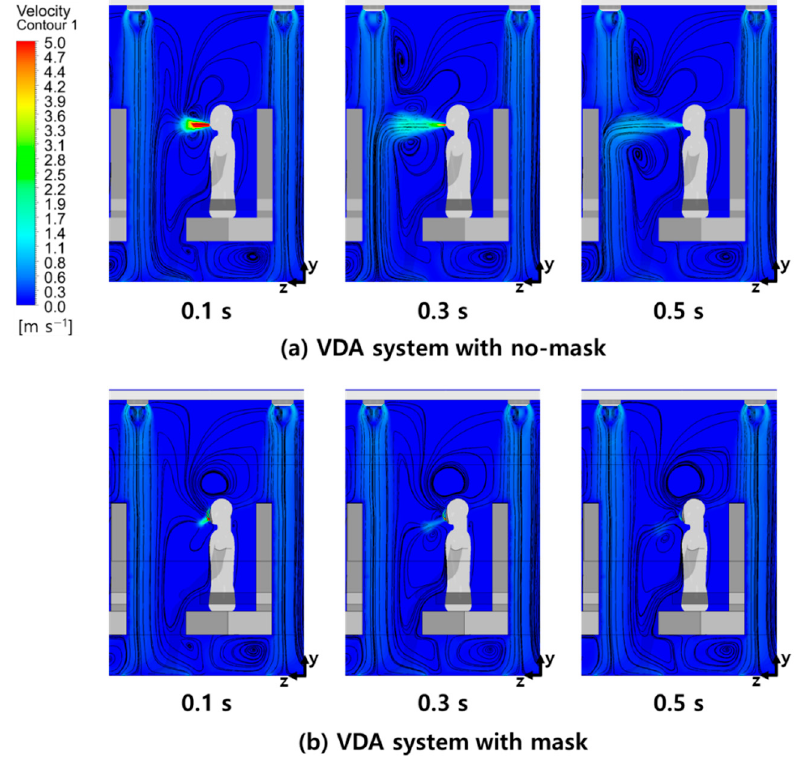
Figure 13. Variation in the velocity distribution and streamline in the VDA system when coughing with and without the mask.